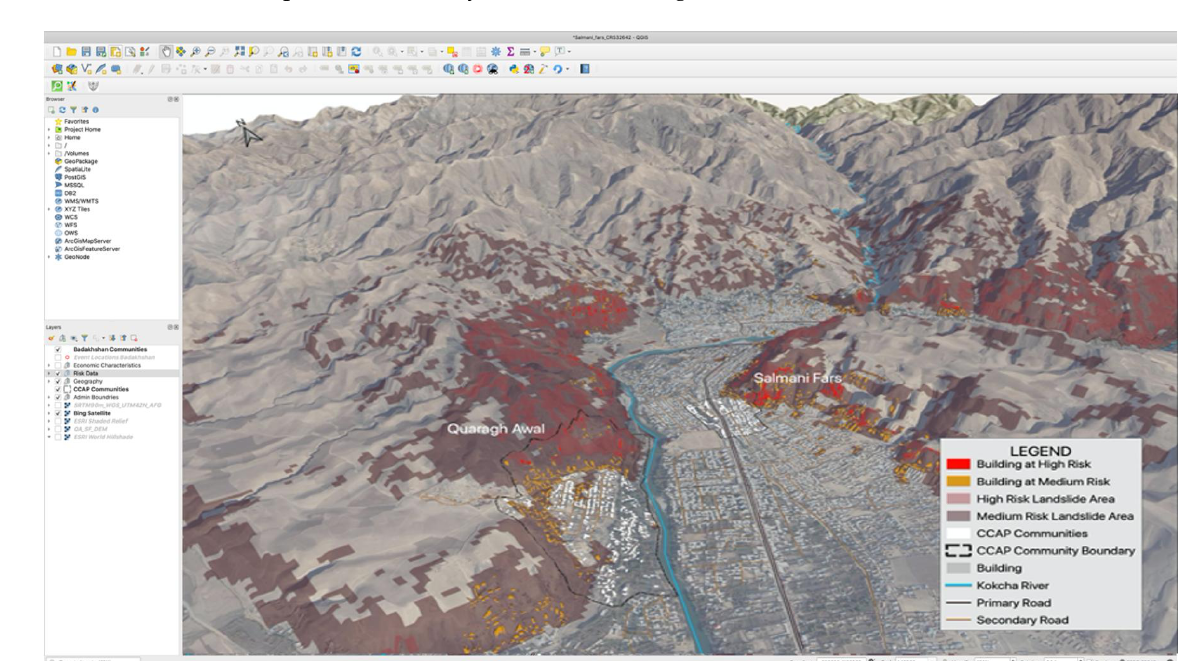
Figure 7. 3D landslide risk map of two communities in Badakhshan province, Afghanistan. This image was provided by Development Monitors